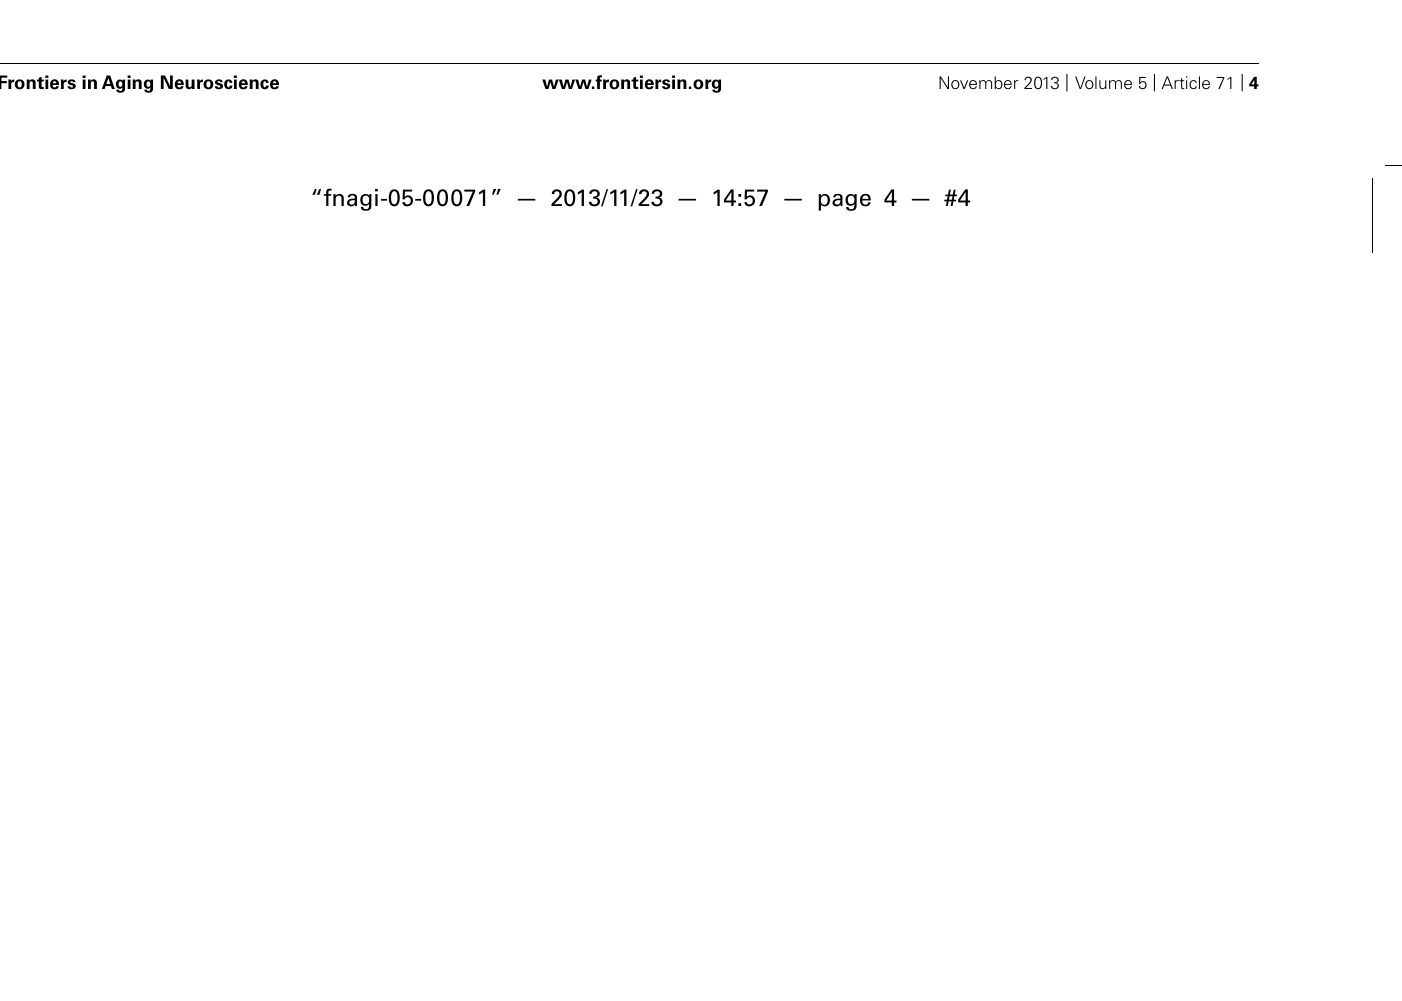
and parietal (D) . The mean diffusivity is given in units of 10 − 3 mm 2 /s. Asterisk indicates the regions with significance. The regions were numbered according to the anatomical automatic labeling